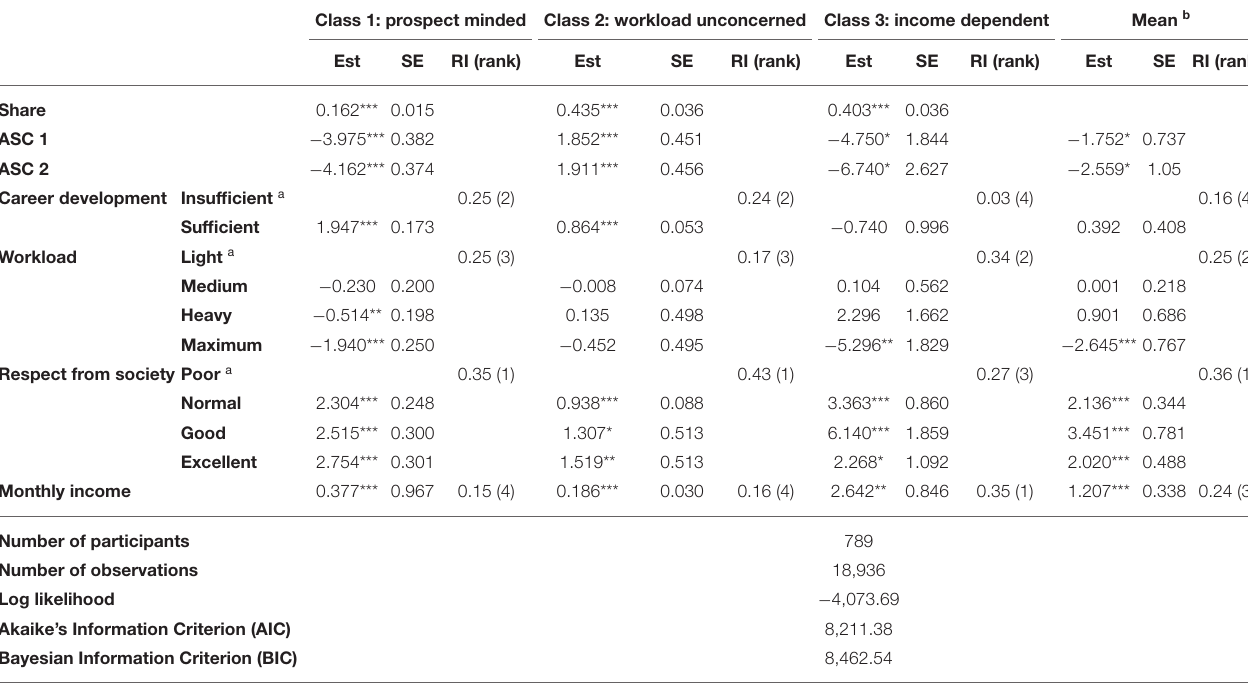
TABLE 2 | The three-class latent-class-logit model estimates. Class 1: prospect minded Class 2: workload unconcerned Class 3: income